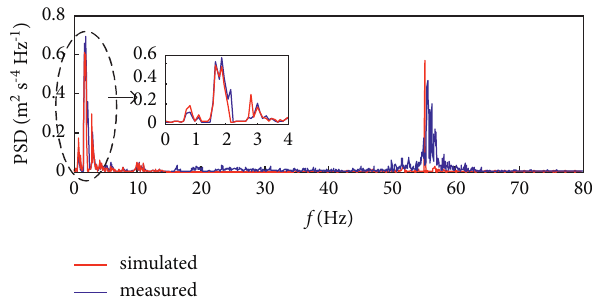
Figure 21: PSD of acceleration in the 4th gear condition. Table 11: RMS values of the test compared with the simulation